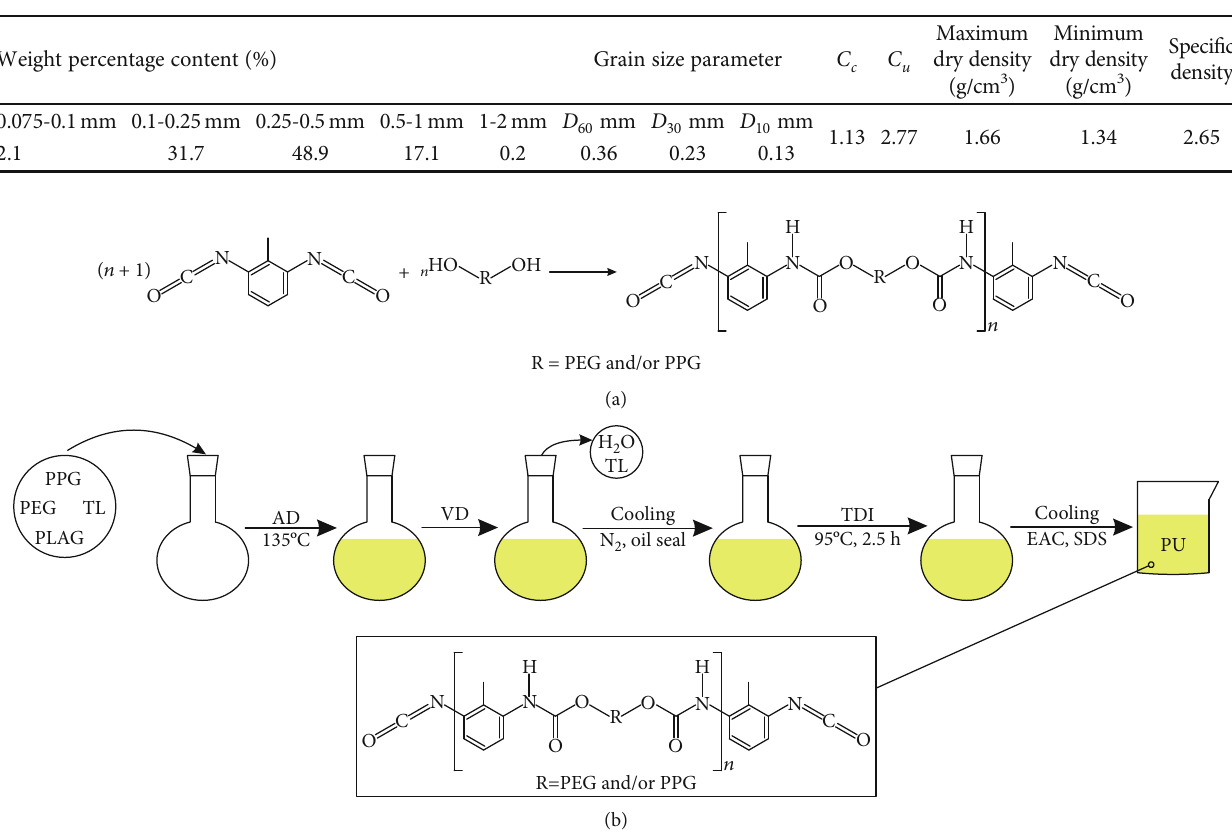
Table 1: The properties of used sand.